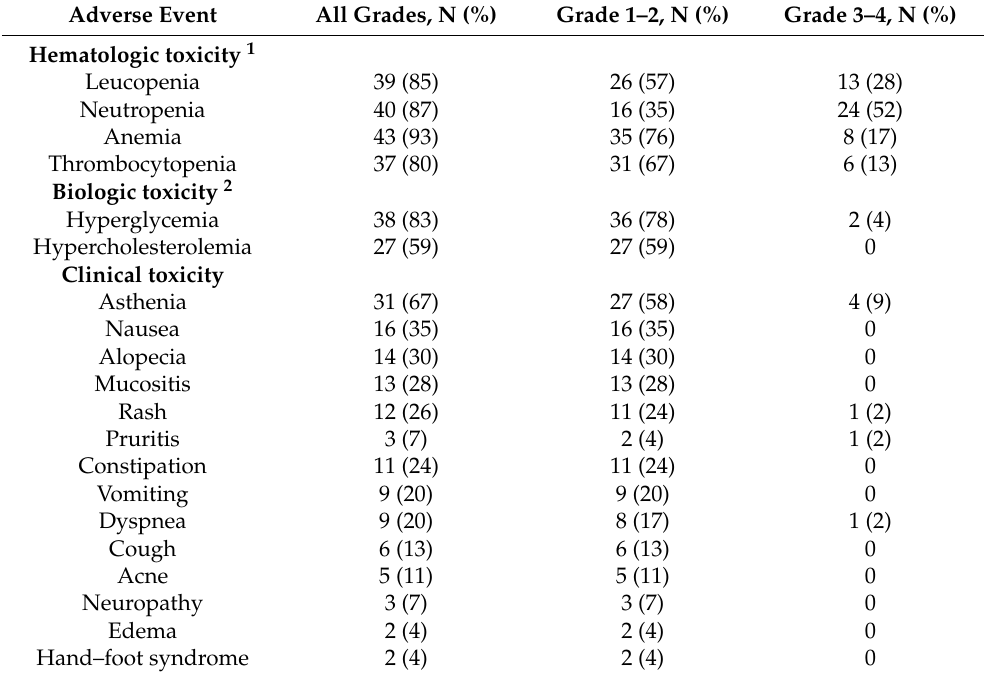
Table 2. Treatment-emergent adverse events observed in patients treated at the recommended everolimus dose (N =